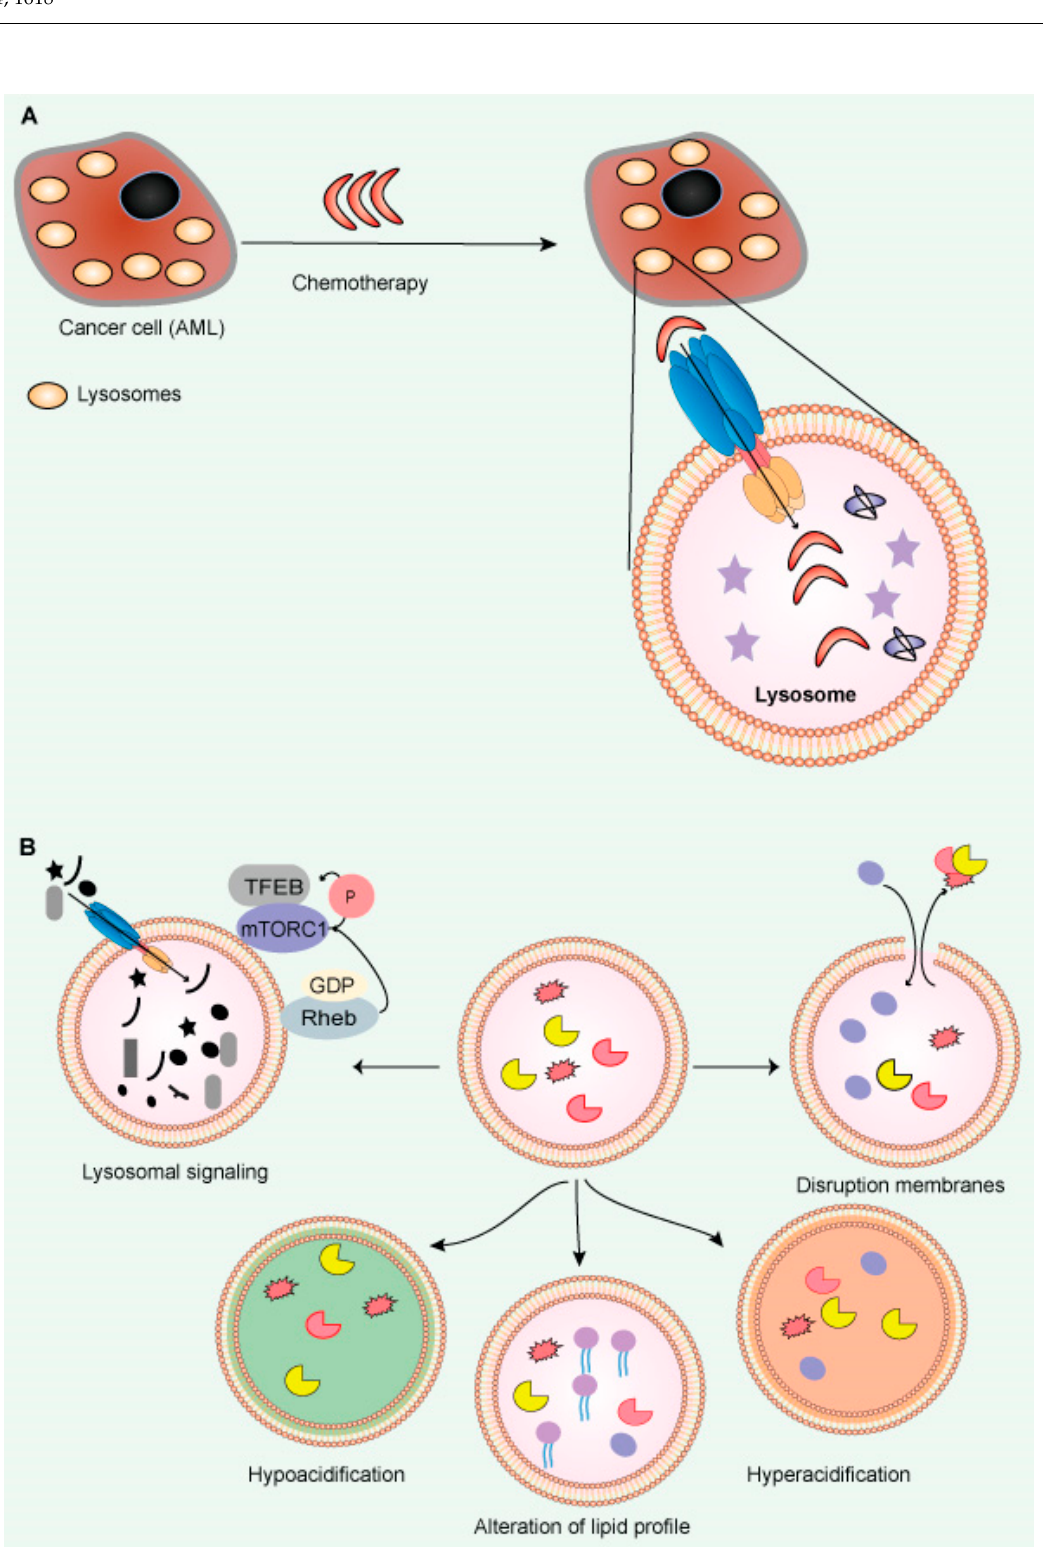
Figure 6. Large lysosomes contribute to resistance to chemotherapy in cancer. ( A ) In cancer cells (AML), enlarged lysosomes may make them more resistant to chemotherapy by concealing thera- peutic chemicals inside lysosomes. ( B ) Lysosome-targeting therapies in cancer (AML): The lysosome membranes are damaged, enabling enzymes to release into the cytosol. Disruption of lysosomal function due to hyper- or hypo-acidification increases medication resistance. Inhibiting pump (v-ATPase) or channel activity may induce lysosome-dependent cell death.